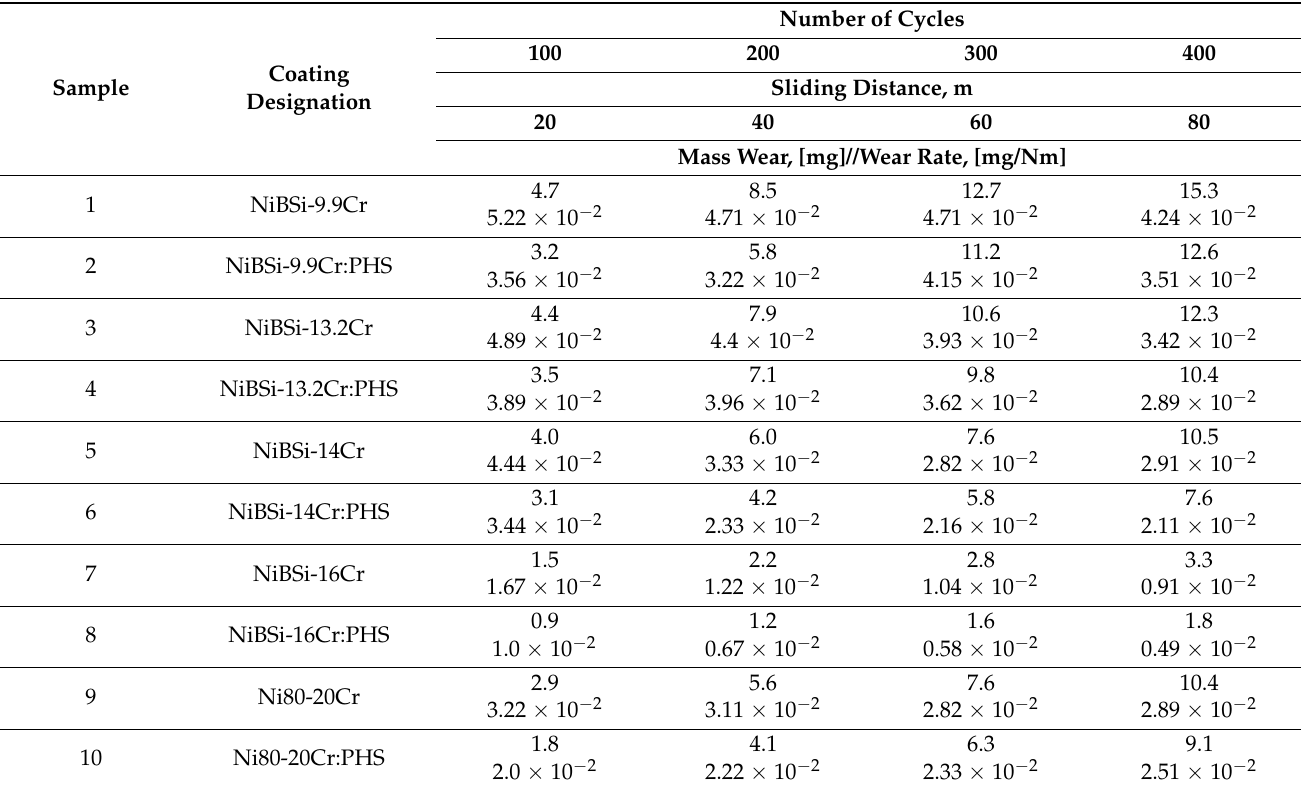
Table 3. Abrasive wear and wear rate of tested